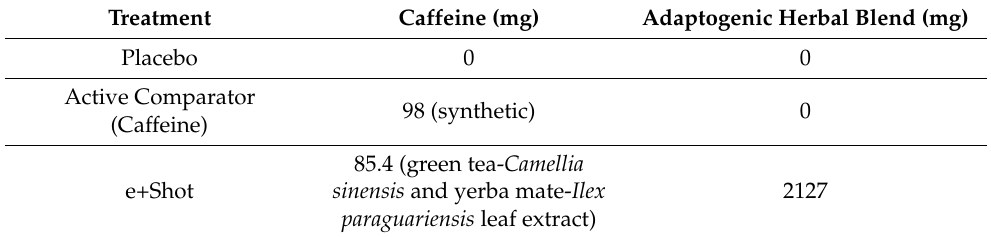
Table 2. Comparison of Study Product